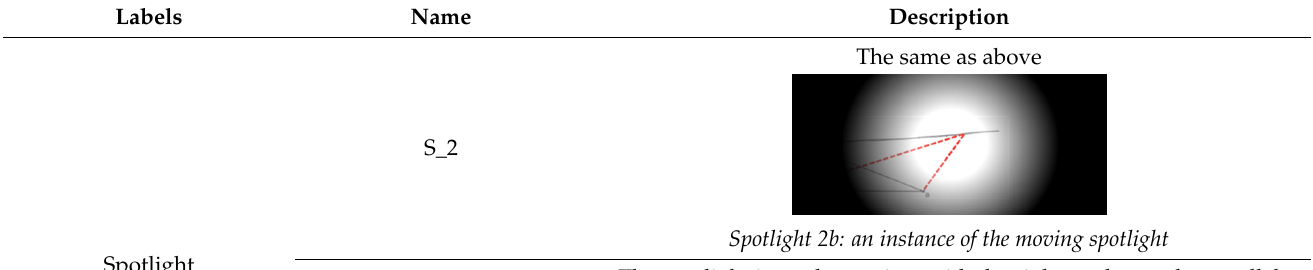
Table 4. Main elements from the analysis of Excerpt 2.